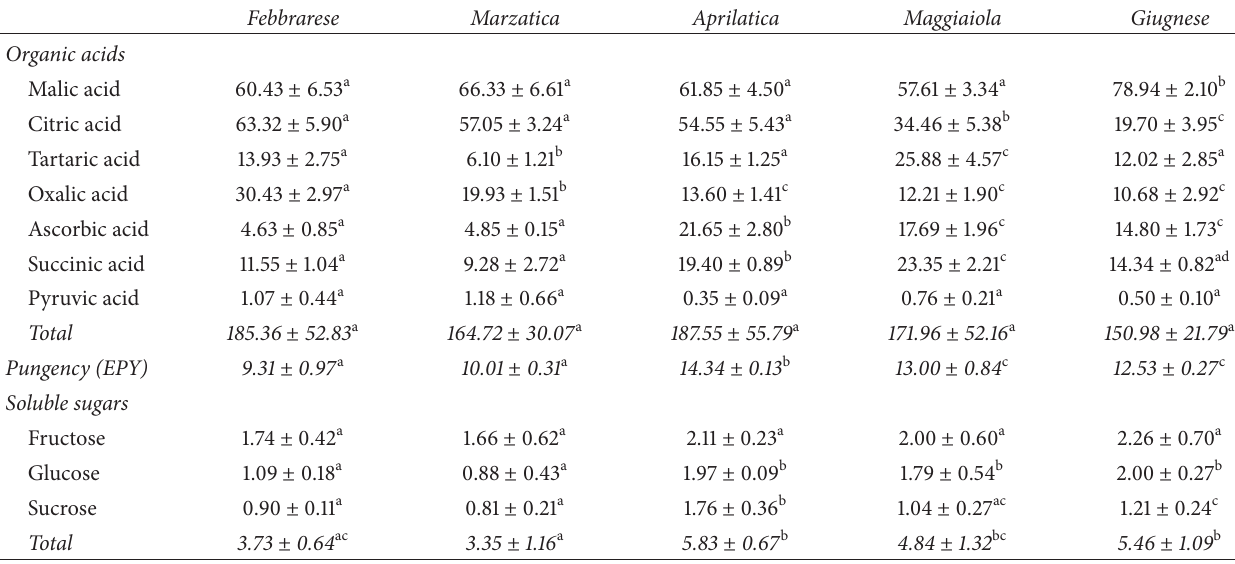
Table 3: Organic acids (mg/100g fw; mean ± SD), sugars (g/100g fw; mean ± SD) content, and pungency ( 𝜇 mol/g fresh weight) of Bianca di Pompei onion